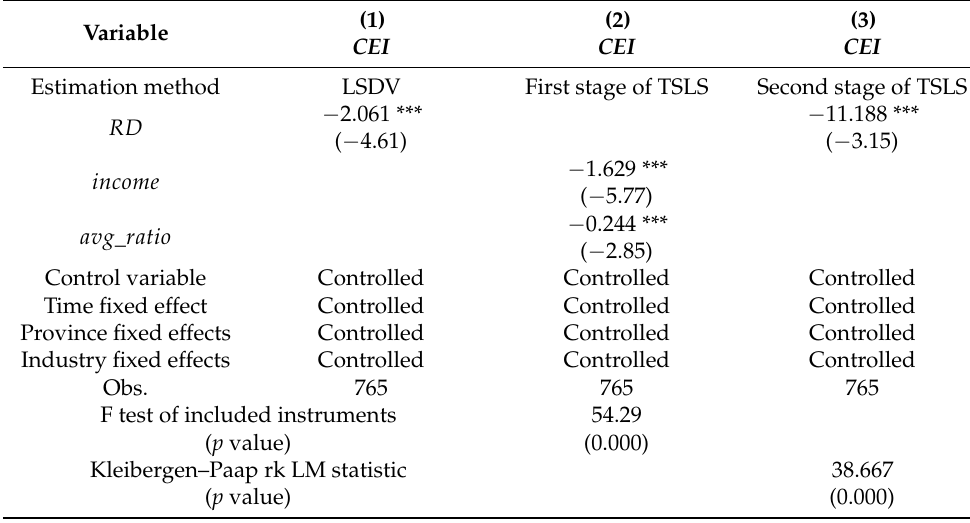
Table 9. Regression results of Two Stage Least Square